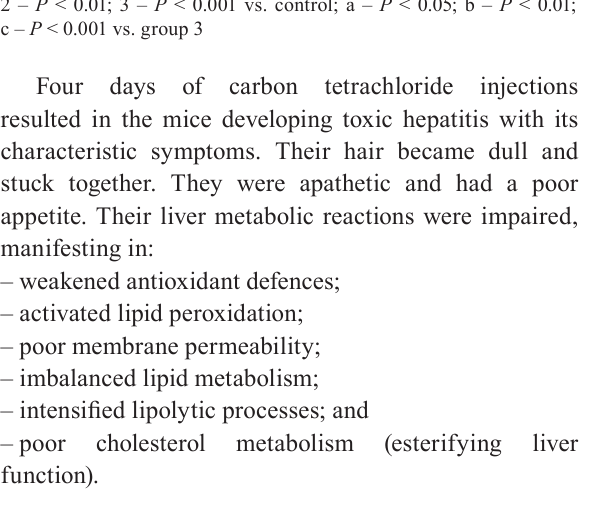
Table 3 Biochemical blood parameters of carbon tetrachloride intoxicated mice and their correction with extract-containing breads (M ± m) Mice groups